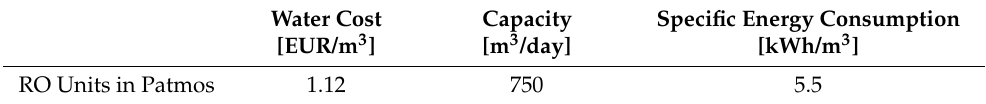
Table 5. Specific energy consumption and specifications of selected RO desalination units in